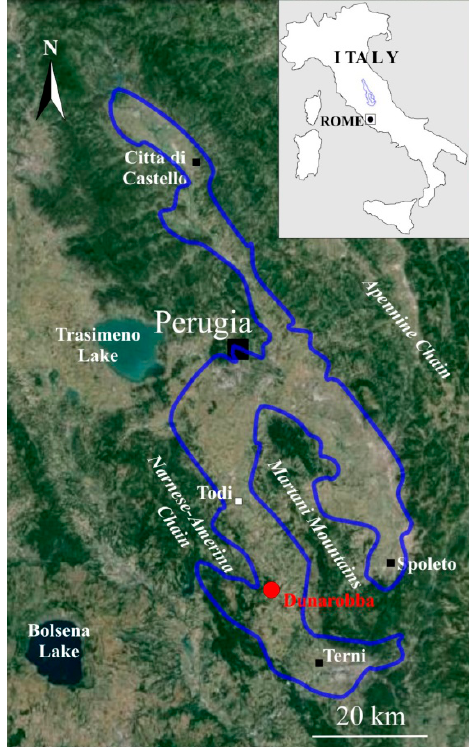
Figure 1. Geographic location of the Dunarobba site (Umbria, Central Italy) and the Cava Nuova section (red dot). The extension of the Tiberino basin during the Quaternary is outlined in blue. Modified from Google Earth image.